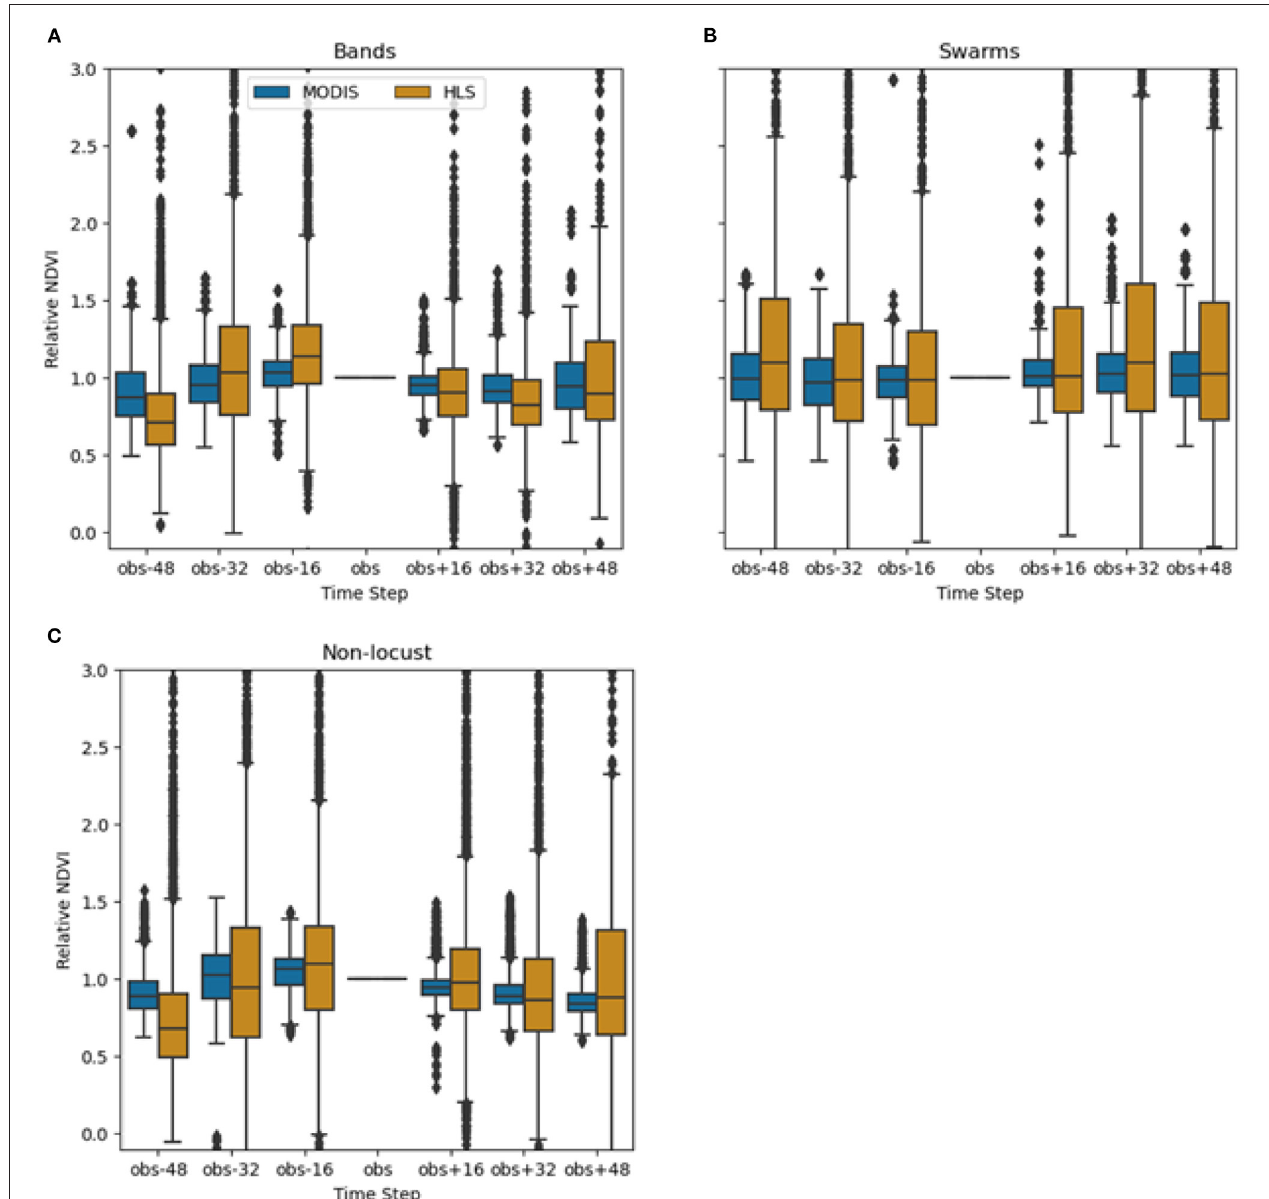
FIGURE 4 | Relative NDVI of MODIS vs. HLS compared over band (A) , swarm (B) , and non-locust (C) sites [ n = 36,820, n = 24,696, n =